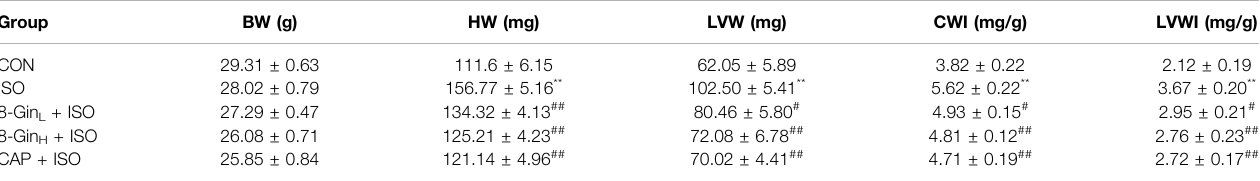
TABLE 1 | Effects of 8-Gin on CWI and LVWI.